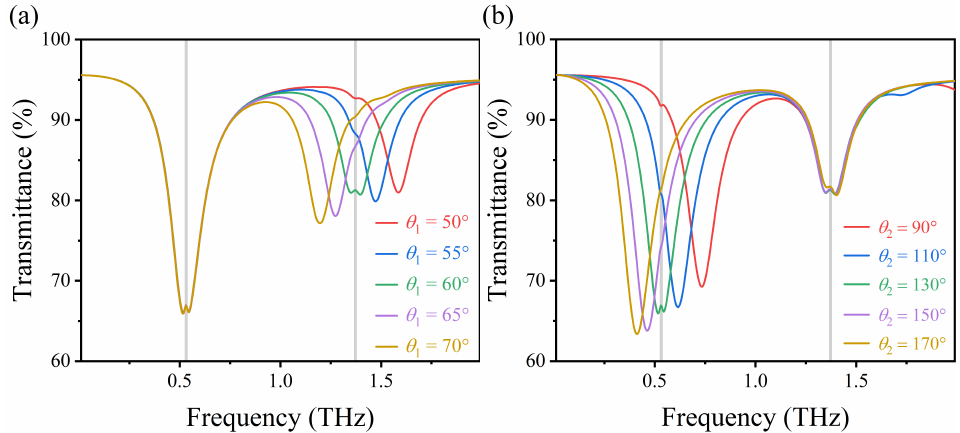
Figure 9. ( a , b ) Transmission spectra of AIGS covered with lactose at different radians θ 1 and θ 2 under vertically incident TM